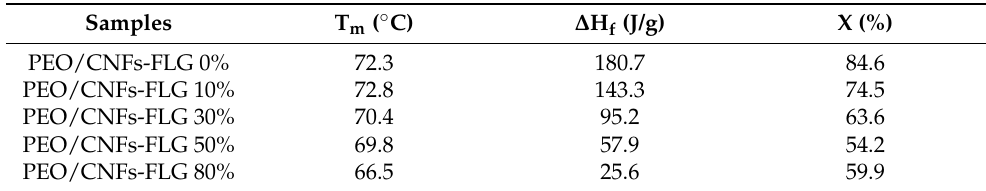
Figure 4. DSC curves of various PEO/CNFs-FLG composites.